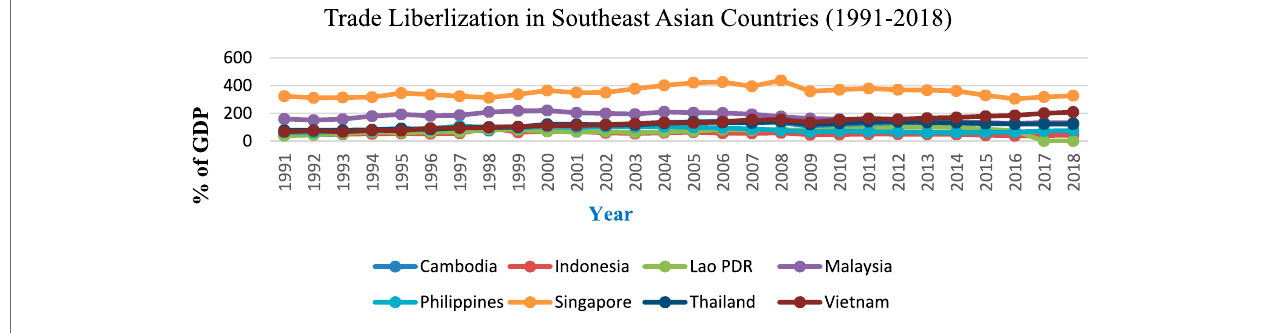
FIGURE 1 | Trade liberalization of Southeast Asian countries.